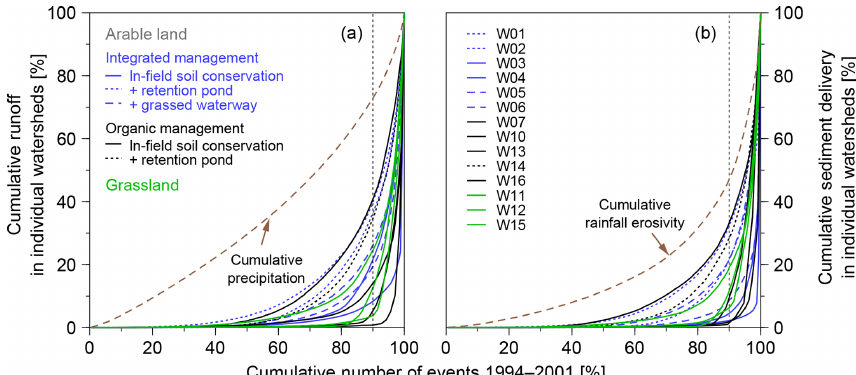
Figure 4. Cumulative event surface runoff (a) and sediment delivery (b) for all watersheds versus the number of observed events in each individual watershed between 1994 and 2001 (except for watershed W11: 1998–2001; and watershed W04 due to an error in most extreme event). All cumulative events are sorted in ascending order. Cumulative precipitation and erosivity is calculated for all erosive events; erosivity was determined following Schwertmann et al. (1987).